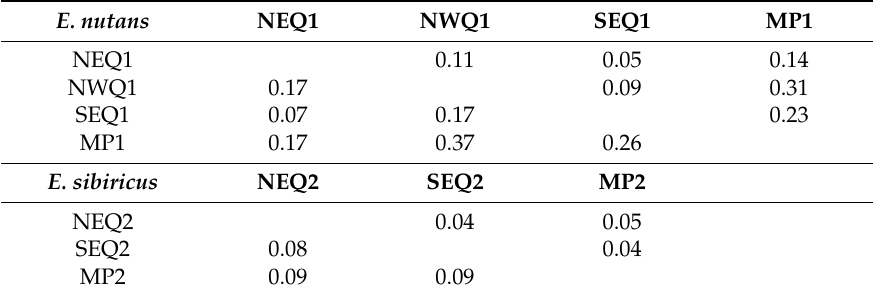
Table 4. Pairwise genetic differentiation (Gst) (below diagonal) and pairwise genetic distance (above diagonal) among four E. nutans and three E. sibiricus groups based on Nei’s original measures. E. nutans NEQ1 NWQ1 SEQ1 MP1 NEQ1 0.11 0.05 0.14 NWQ1 0.17 0.09 0.31 SEQ1